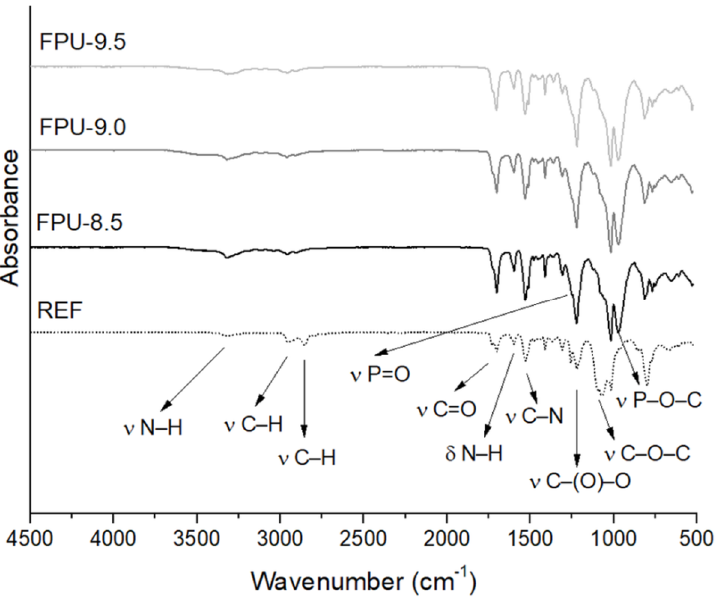
Figure 2. FTIR spectra of polyurethanes containing different amounts of phosphorus polyol (FPU-9.5, FPU-9.0, FPU-8.5) and reference material (REF). Table 2. The values of hydrogen bond index (R), degree of phase separation (DPS), degree of phase mixing (DPM), and hard (HS) and soft (SS) segment contents of the